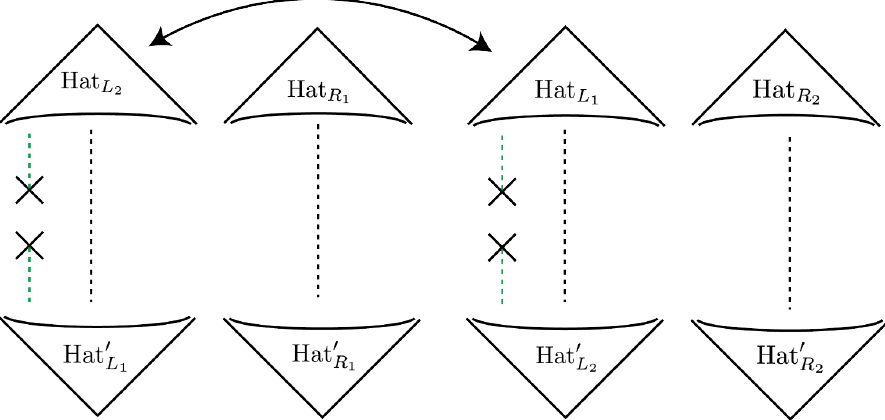
Figure 10. This figure illustrates what happens if the frozen portion of the geometry is only connected to one hat, in this case Hat L . The green-dashed lines schematically represent the frozen portion of the geometry. In this case, Hat L from replica 1 can be swapped with Hat L from replica 2 and so the dominant saddle will just be two copies of the saddle which dominates the norm, h HH f | HH f i . In other words, Tr [ ρ 2 ] = h HH f | HH f i 2 where ρ is the unnormalized density matrix. The double-headed arrow indicates that the left hats from each replica have been